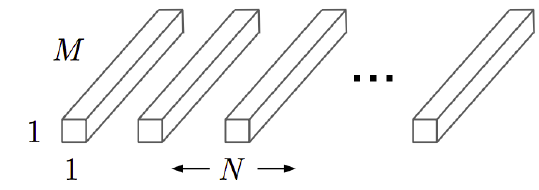
Figure 6. Pointwise convolution kernels [14].